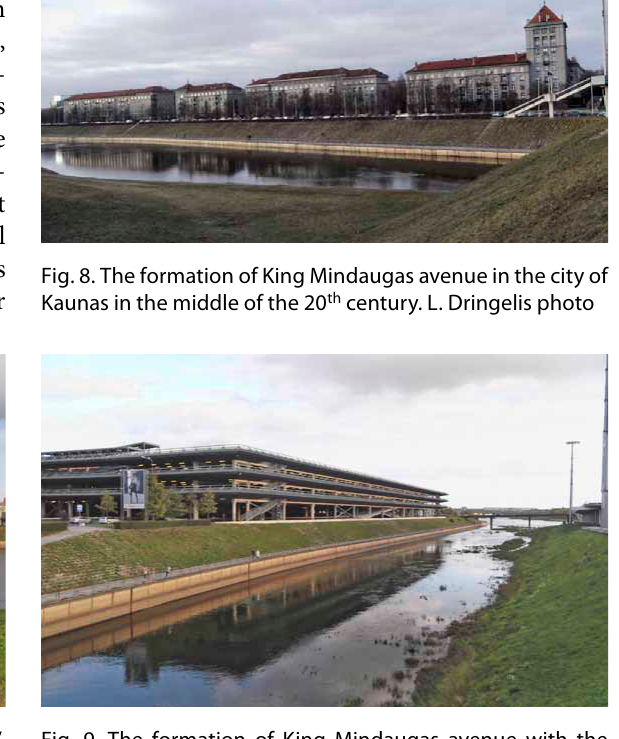
itfig. 7. The old Town of Kaunas is the city’s “visiting card”. l. Dringelis photo